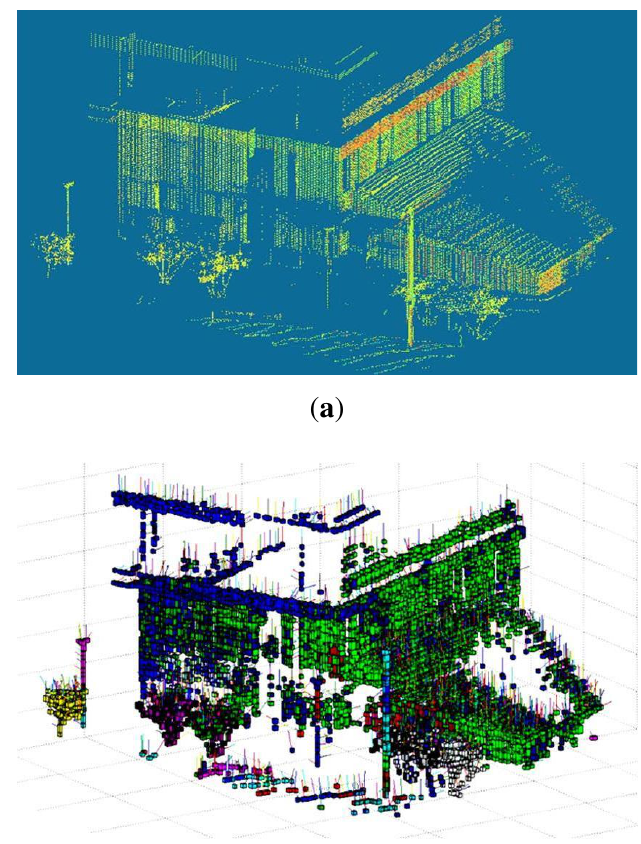
Figure 6. (a) 3D data points—shows 3D data points of data set 1. (b) Voxelisation